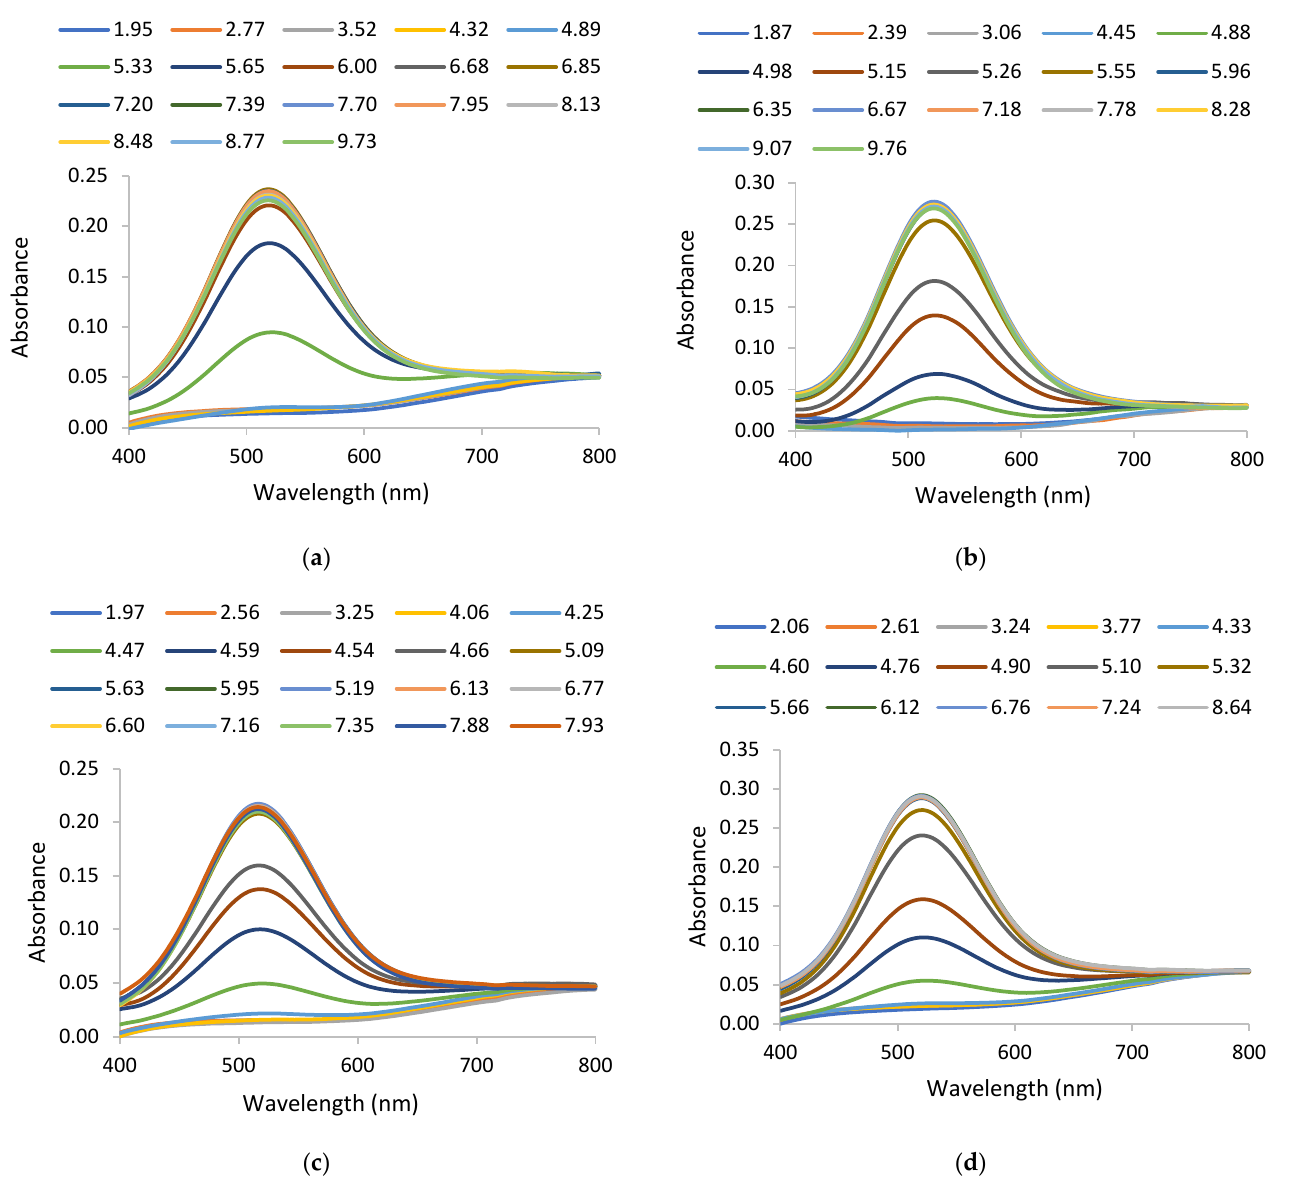
M of GLH and 2.69 Figure 5. Electronic spectra of solutions containing ( a ) Cu-GLH (3.04 Figure 5. Electronic spectra of solutions containing ( a ) Cu-GLH (3.04 × 10 − 3 M of GLH and M of copper(II)), ( b ) Cu-Sar-LH (2.93 M of Sar-LH and 2.58 M of cop- −3 2.69 × 10 − 3 M of copper(II)), ( b ) Cu-Sar-LH (2.93 × 10 − 3 M of Sar-LH and 2.58 × 10 − 3 M of × 10 per(II)), ( c ) Cu-GFH (3.09 M of GFH and 2.55 M of copper(II)) and ( d ) Cu-Sar-FH −3 −3 −3 copper(II)), ( c ) Cu-GFH (3.09 × 10 − 3 M of GFH and 2.55 × 10 − 3 M of copper(II)) and ( d ) Cu-Sar-FH × 10 × 10 × 10 M of Sar-FH and 2.97 M of copper(II)). (3.66 −3 −3 (3.66 × 10 − 3 M of Sar-FH and 2.97 × 10 − 3 M of × 10 × 10 −3 −3 × 10 × 10